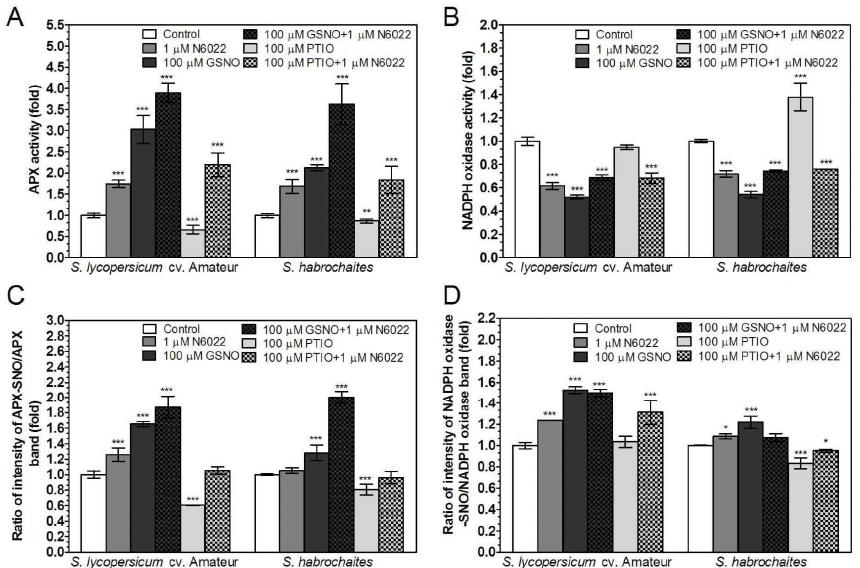
Figure 3. E ff ects of RNS modulators on APX and NADPH oxidase activity and S-nitrosation status in tomato roots. ( A ) APX activity was evaluated spectrophotometrically at 25 ◦ C by monitoring the consumption of H 2 O 2 at λ = 2 90 nm. ( B ) NADPH oxidase-catalysed O 2 − generation in purified membrane fractions from tomato roots was determined spectrophotometrically at 25 ◦ C by reduction of the tetrazolium salt XTT. S-nitrosation status for ( C ) APX and ( D ) NADPH-oxidase was determined as the ratio of intensities of detected S-nitrosylated protein vs. total protein by the Western blot method quantified using ImageJ 1.33 software (Supplementary Figure S3). The data are presented as means ± SD ( n ≥ 3). Significantly di ff erent means from the control values are denoted by asterisks (ANOVA, * p < 0.05, ** p < 0.01, *** p < 0.001). Additionally, to test whether APX and NADPH oxidase activities were modulated by S-nitrosation, we quantified APX and NADPH protein in S-nitrosated protein fraction purified by